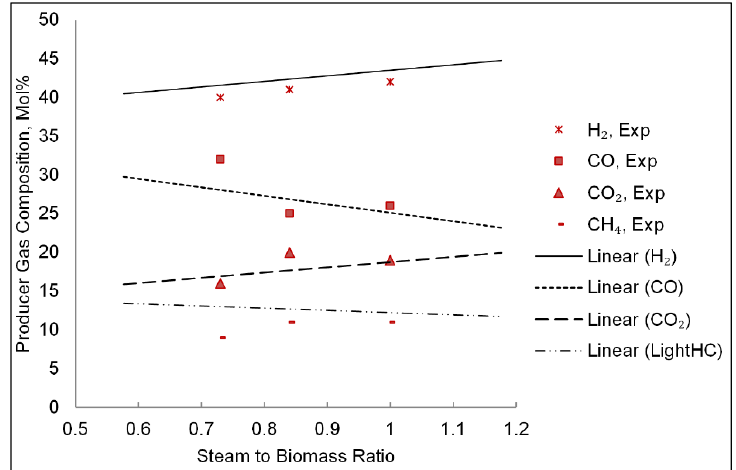
Figure 6. Comparison of the producer gas composition resulted from the simulation with the experimental data [32], T = 850